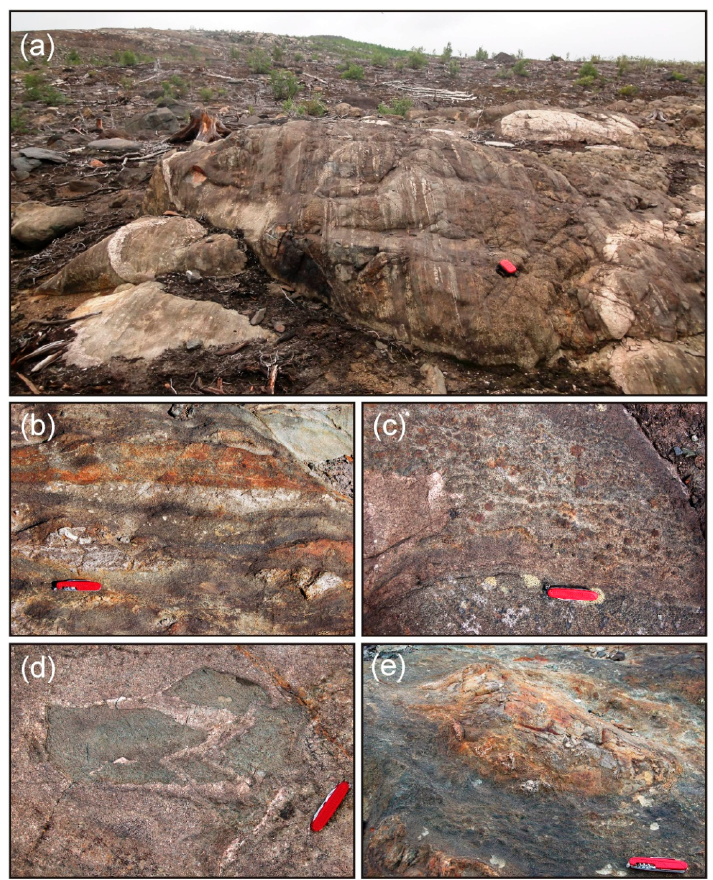
Figure 3. Geological outcrops within the DW block: banded diorite-gneiss ( a ); alternation of amphibolite and diorite-gneiss ( b ), garnet porphyroblasts in diorite-gneiss ( c ), torn boudins of amphibolite in diorite-gneiss ( d ), and boudin of garnet amphibolite with oxide mineralization ( e ). The macro-banding was expressed by the alternation of massive and strongly schistose diorite- gneiss layers (with a thickness of a few meters; Figure 3a). The strike of banding was nearly west (280°); the rock contacts dipped at an angle of 60–65° to the southwest. In turn, the banded texture or micro-banding of diorite-gneisses was caused by the alternation of leucocratic layers, where quartz and feldspar dominated with more melanocratic ones, where biotite and amphibole prevailed (Figure 3b and Figure 4). Elongated schlieren of large garnet porphyroblasts with various shapes and sizes (up to 2–3 cm across) were clearly visible on the weathered surface of schistose diorite-gneisses (Figure 3c, Figure 5, and Figure 6), in addition to aggregates (nests and schlieren) of black tourmaline (Figure 6).